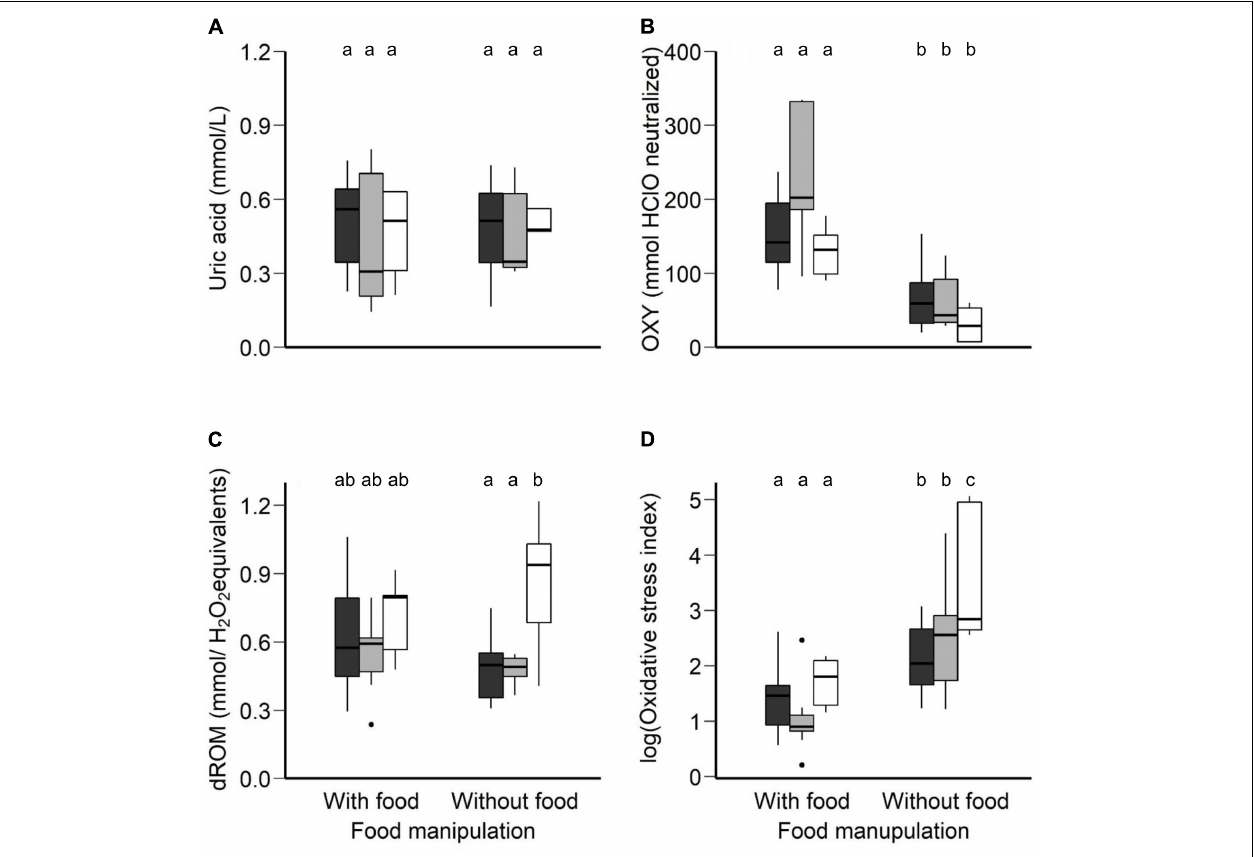
FIGURE 3 | (A) Uric acid (mmol/L), (B) OXY (mmol HClO neutralized), a metric for non-enzymatic antioxidant capacity, (C) dROM (mmol/H 2 O 2 equivalents), a metric of oxidative damage, in plasma concentration and (D) oxidative stress index (log-transformed), calculated as the ratio of the oxidative damage to the